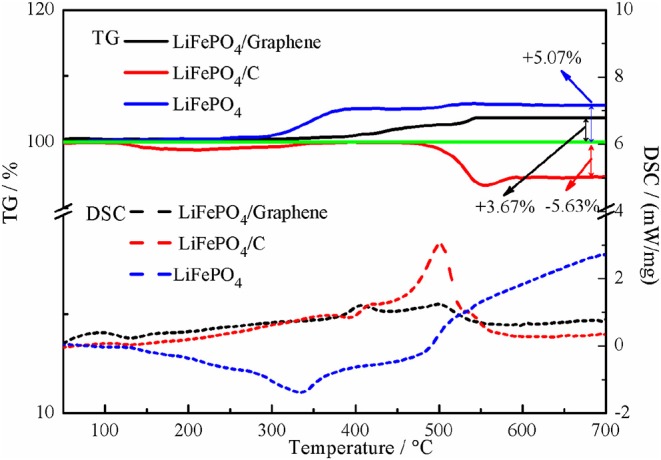
TG-DSC curves of LiFePO4/graphene, LiFePO4/C composites, and LiFePO4.